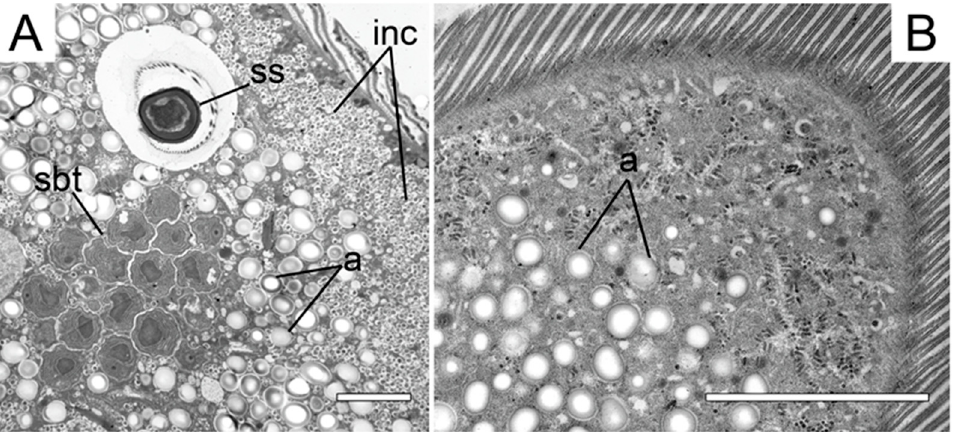
Figure 4. Fine structure of the cytoplasm in infected and healthy Polyrhabdina pygospionis . ( A ) Eugregarine infected with Metchnikovella spiralis . Spore sac ( ss ) and sporoblasts ( sbt ) are seen in the cytoplasm along with some amylopectin granules ( a ), while the periphery of the cell is full of small round inclusions ( inc ). ( B ) Healthy eugregarine. There are numerous amylopectin granules in the cytoplasm and no small inclusions in the periphery. Scale bars: ( A )—3 μ m, ( B )—5 μ m.